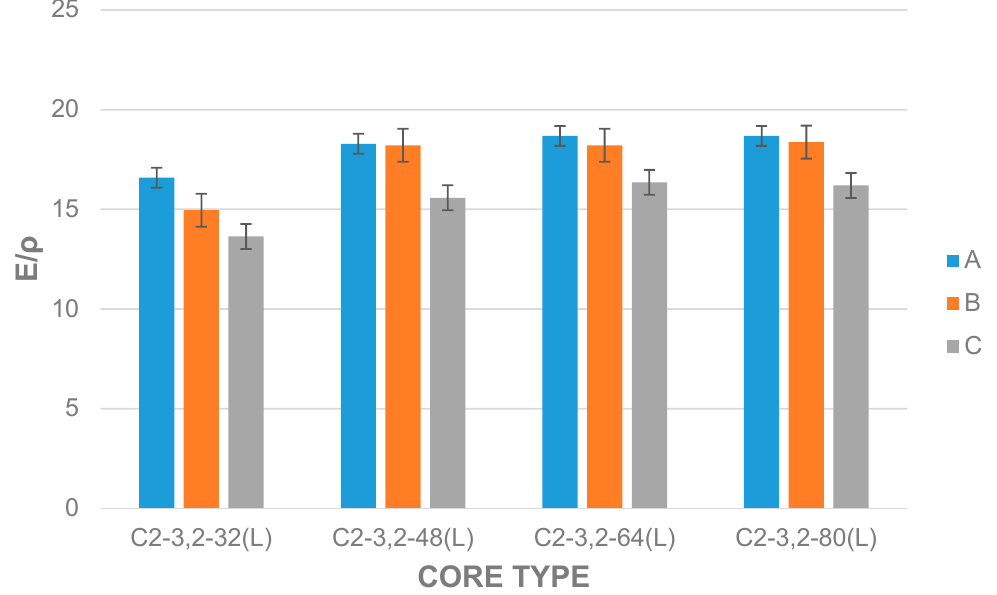
Figure 8. Specific bending modulus of sandwich constructions (A–C); honeycomb used: C2 type, C2 type honeycomb with unified mesh size 3.2 mm and different densities (32, 48, 64, and 80) kg·m − 3 , L orientation.